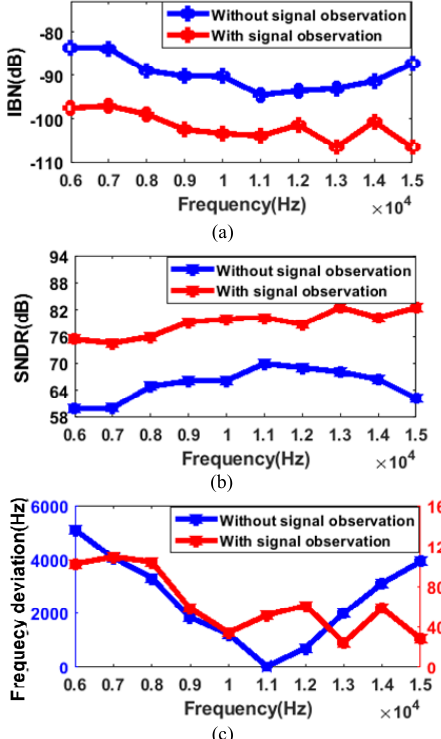
Figure 16. Measured in-band noise (IBN), SNDR, and frequency deviation with disabled and enabled signal observation in ( a ), ( b ) and ( c ) with input signal frequency ranging from 6 to 15 kHz. Table 2. Performances at di ff erent temperature points with an 11 kHz sinusoidal input